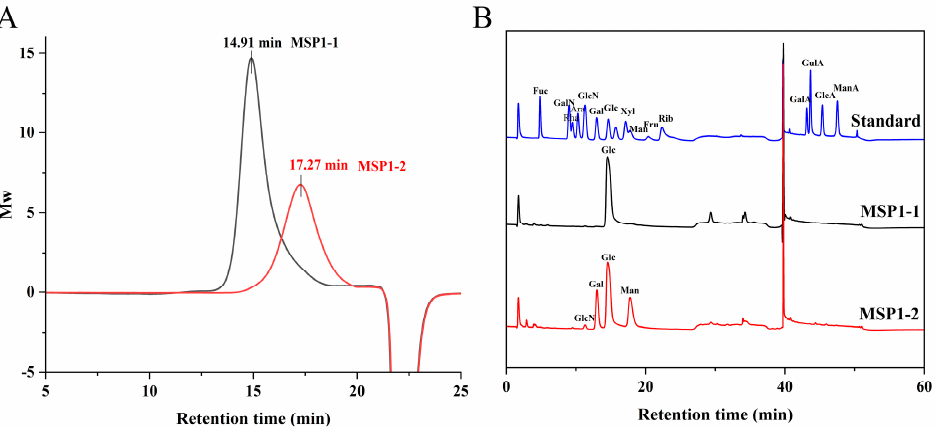
Figure 1. ( A ) High-performance gel filtration chromatography (HPGFC) elution profiles of MSP1-1 and MSP1-2. ( B ) Chromatographic analysis results of mixed monosaccharide standard, MSP1-1, and